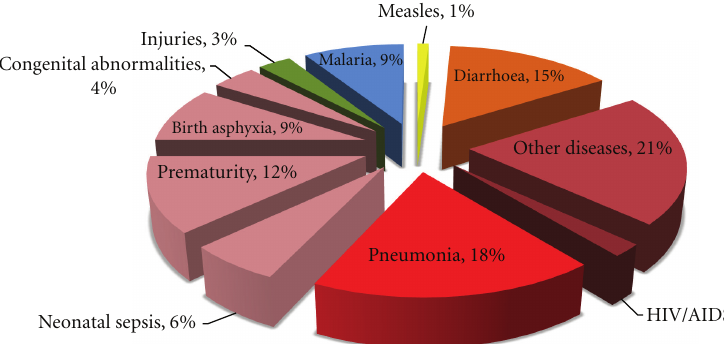
Figure 1: Causes of death among children under 5 years of age (data from